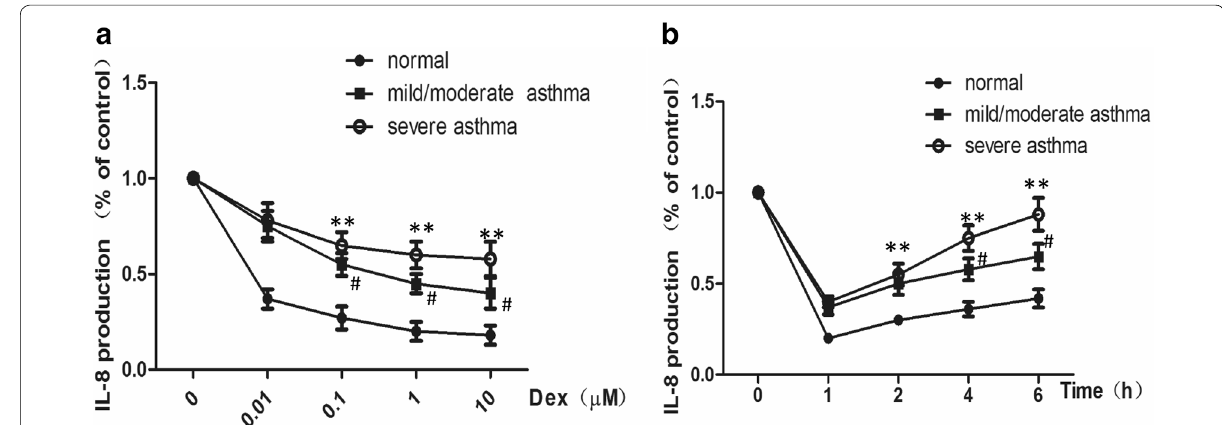
Fig. 1 PBMCs with severe asthma showed dexamethasone insensitivity in the TNFα-induced IL-8 release test. a Dexamethasone inhibits IL-8 releasing of PBMCs in dose-dependent manner, which is impaired in asthma population, especially in severe asthma subgroup. b Dexamethasone added 1–6 h after TNFα stimulation. It showed dexamethasone inhibited- IL-8-releasing gradually diminished in a time-dependent manner. Dexamethasone inhibition rate decreased in asthma population, especially in severe asthma subgroup. IL-8 releasing level is relative to the level of group without dexamethasone treatment. **p < 0.01 significant difference when compared to severe asthma group; # p < 0.05 significant